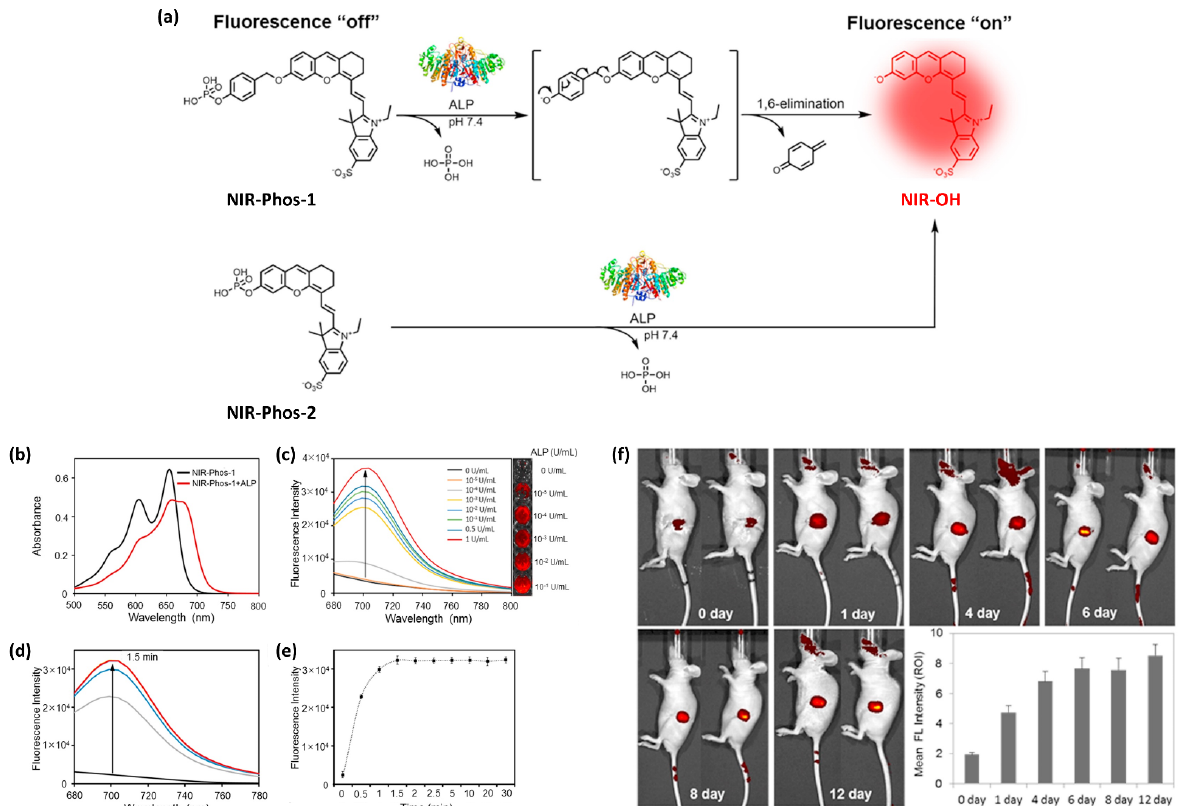
Figure 2. ( a ) Schematic illustration of the fluorescence “turn-on” process of near-infrared (NIR) probes triggered by alkaline phosphatase (ALP). ( b ) Ultraviolet-visible absorption of NIR probes (5 μ M) and ( c ) fluorescence emission spectra and fluorescence images (excitation = 685 nm) of NIR probes (5 μ M) with different concentrations of ALP (0–10 − 5 U mL − 1 ; the reaction time for all concentrations was 1.5 min) in Tris-HCl buffer (10 mM, pH 7.4). ( d ) Fluorescence emission spectra of NIR-Phos-1 (5 μ M). ( e ) Fluorescence emission spectra of NIR-Phos-1 (5 μ M) with ALP (0.1 U mL − 1 ) over different time periods (0–30 min) at room temperature. The spectra were obtained at 0.5 min intervals. ( f ) Fluorescence images of NIR-Phos-1-labeled CDHA scaffolds implanted in mice. Reprinted with permission from Ref. [44] . Copyright 2018, Elsevier.